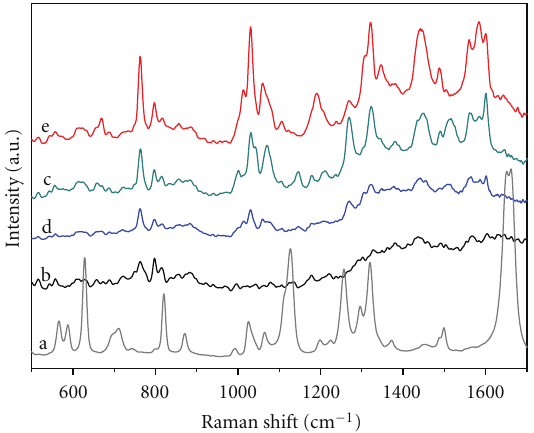
Figure 3: Raman spectrum of solid pure L-ascorbic acid (scaled by factor 0.25)(spectrum a). SERS spectrum of individual gold nanospheres in solution recorded under NIR excitation (spectrum b). SERS spectra of PEG-GENs obtaine with increasing volumes: 20 μ L (spectrum c), 50 μ L (spectrum d), and 100 μ L (spectrum e) mPEG-SH, recorded under NIR excitation.